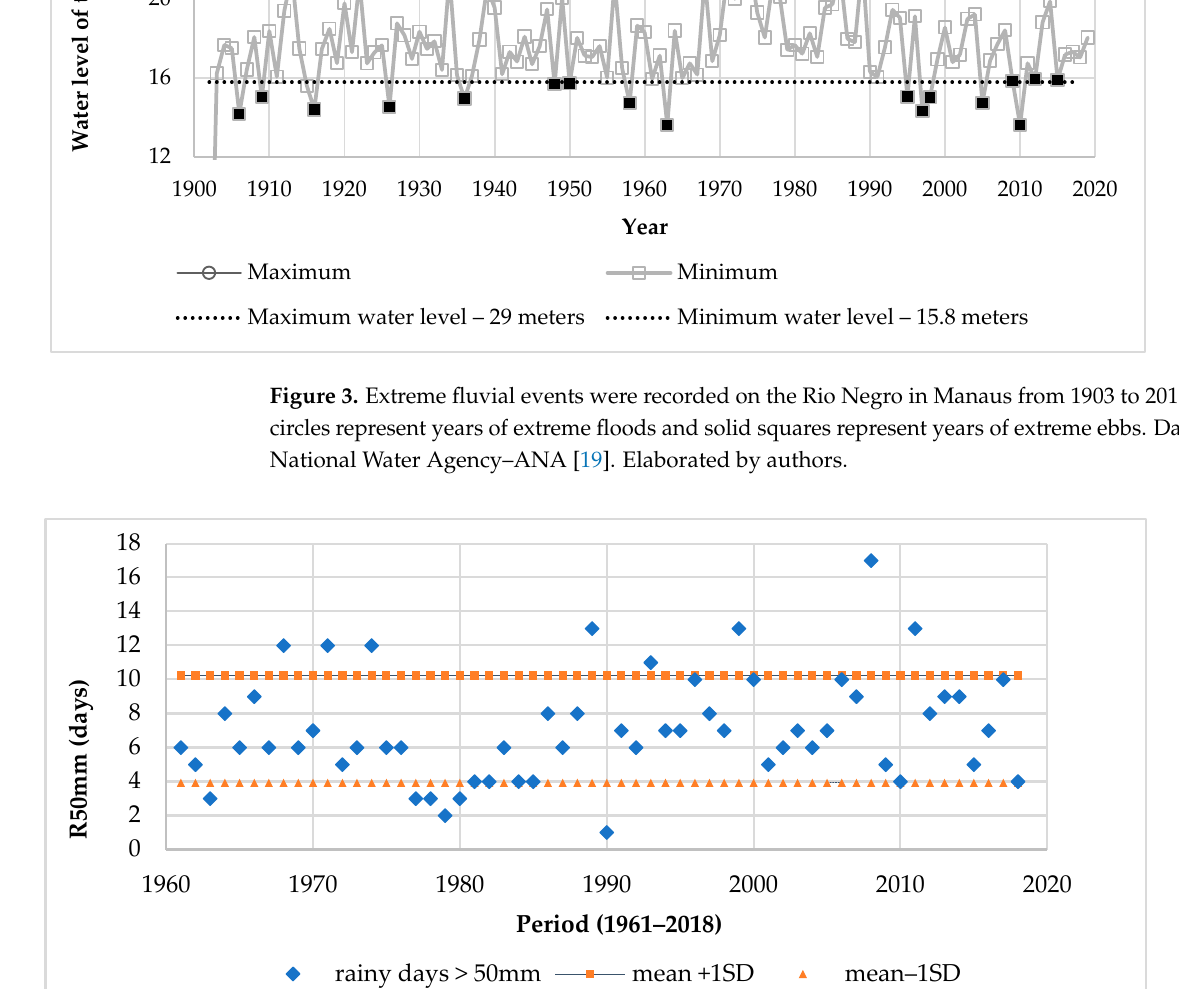
Figure 5. Temporal distribution of the PDU index (annual percentage of wet days) in the period from 1961 to 2018. Data from INMET station 82331, 2020. Elaborated by authors. When analyzing the data from the historical period, the average maximum daily temperature found for the period from 1961 to 2018 was 31.8 °C. For this study, the mean was rounded to 32 °C and then the analysis of the number of annual days of temperature above this value was performed (Figures 6–8).